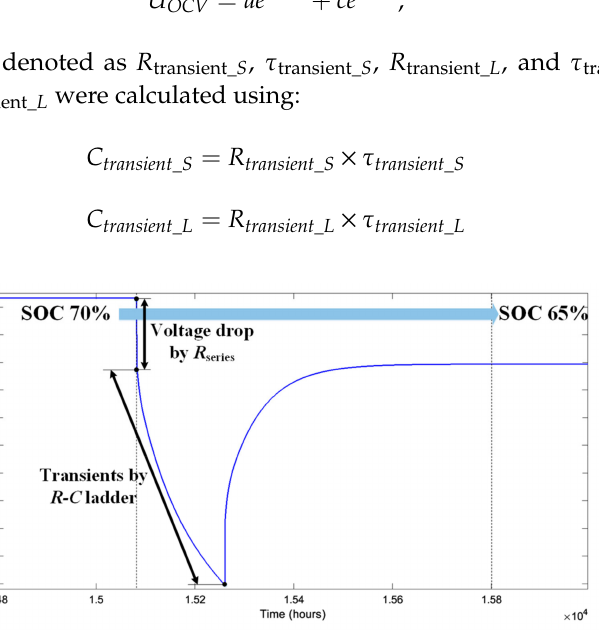
Figure 4. One pulse from the discharge